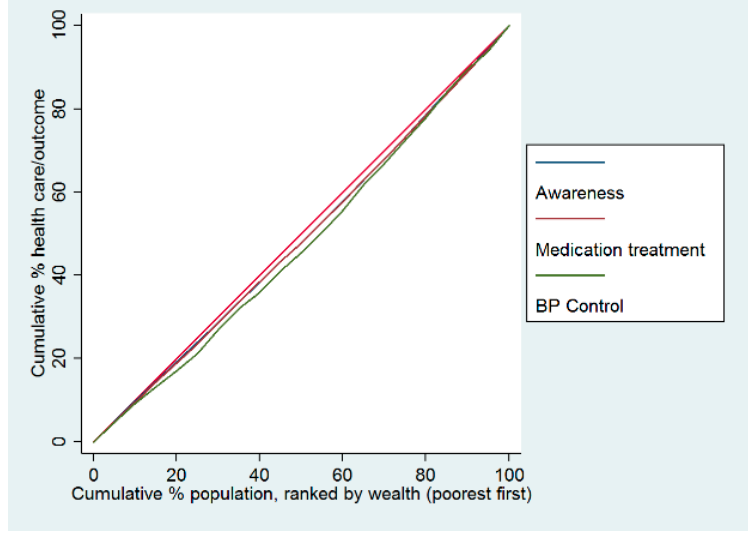
Figure 1. Concentration curves of healthcare for adults with hypertension in China in 2015.